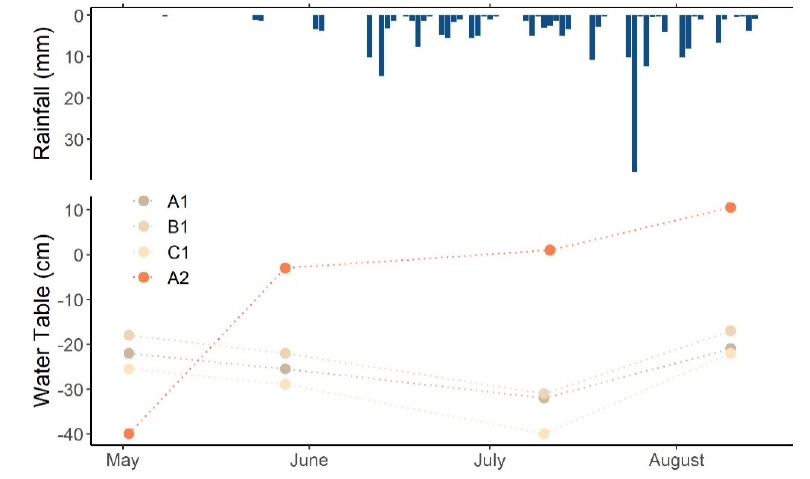
Figure 4. Rainfall and water table during the study period (2 May to 10 August 2019). Rainfall data are from Sandy Lake Auto weather station [28] located approximately 13 km northwest of the Pelican Mountain research site. Water table data represent manual measurements relative to ground surface (0 cm) in each well; negative values show water table below ground. In the unburned section, water table varied within about 15 cm during the sampling events, with the lowest water table recorded in July. After heavy rainstorms in the middle and late July, the water table rose to the levels observed in the beginning of the monitoring